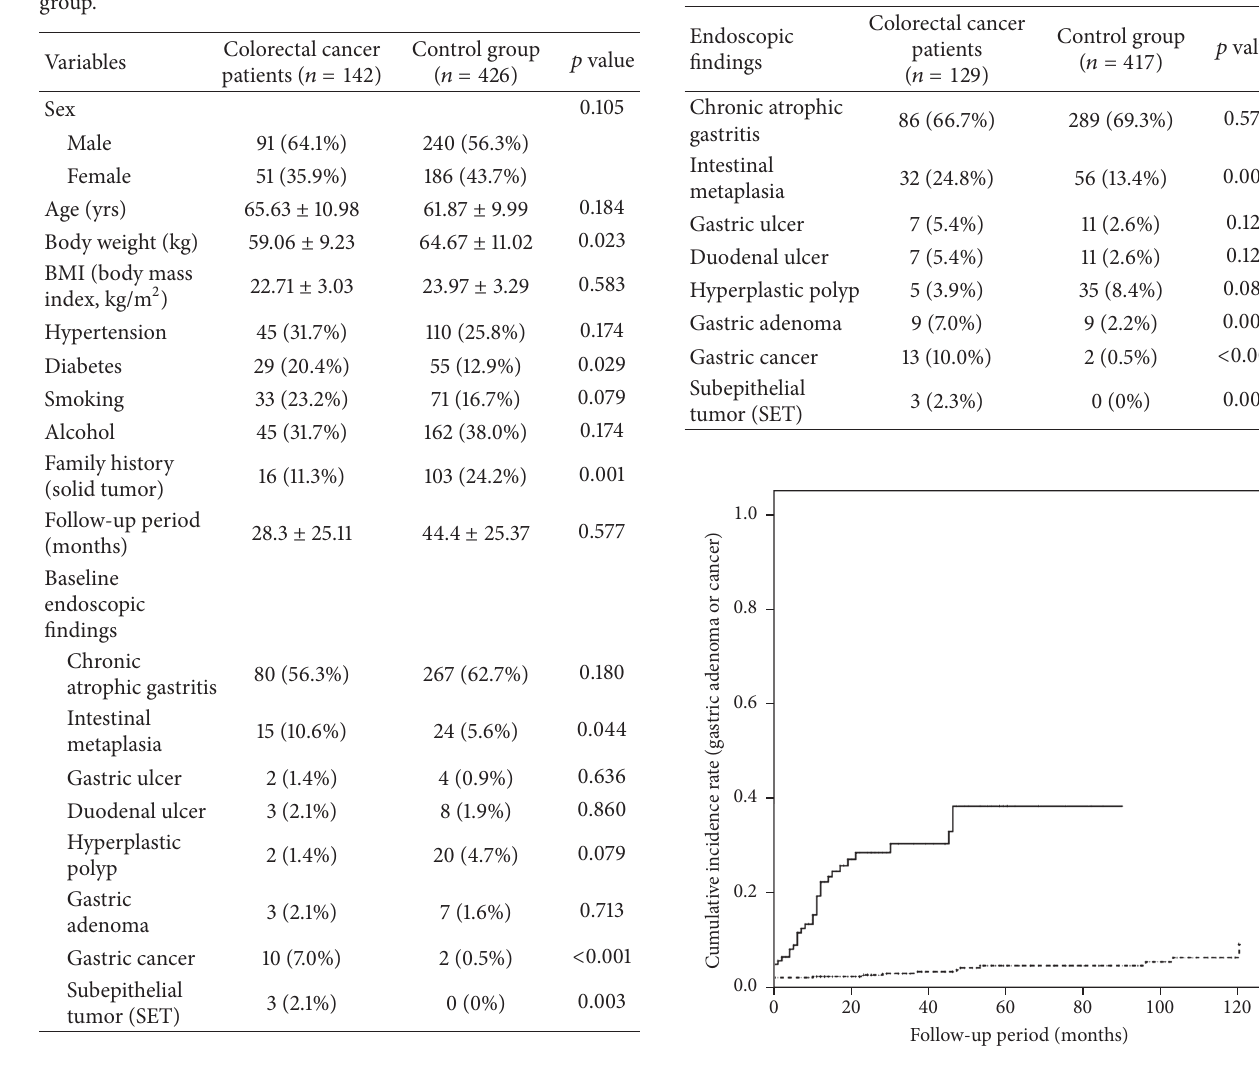
Table 4: Follow-up endoscopic findings in colorectal cancer group and control group.